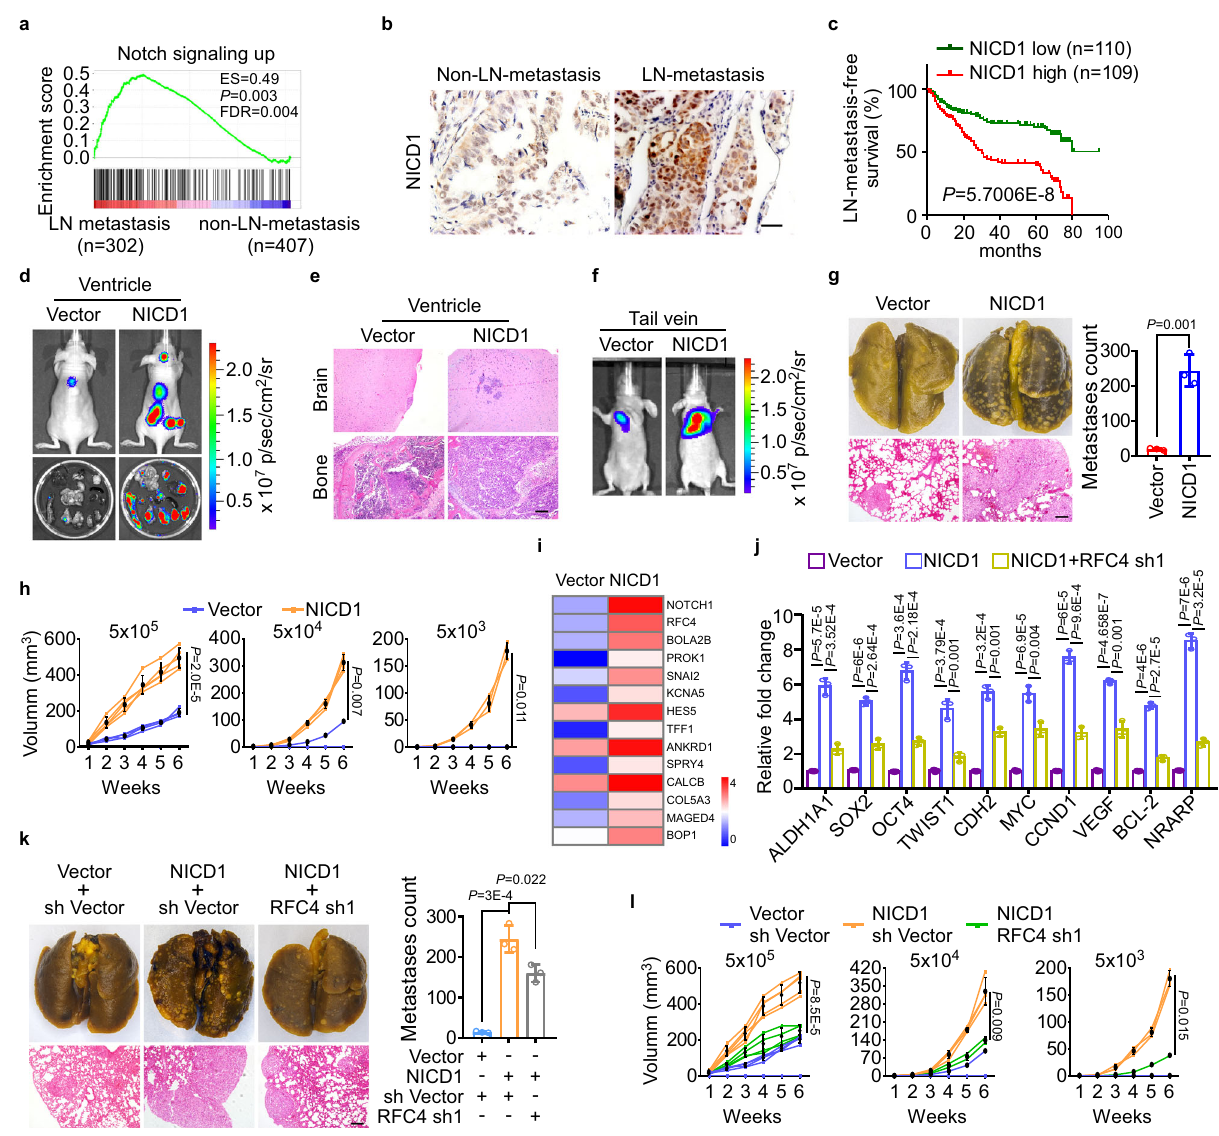
Fig. 1 RFC4 is essential for Notch activation-induced metastasis and stemness of NSCLC. a GSEA analysis of gene expression pro fi les of NSCLC patients with or without lymphatic node (LN) metastasis in the TCGA lung cancer datasets by Kolmogorov – Smirnov test. b IHC determined NICD1 expression in primary tumors of our cohort of 219 NSCLC patients with or without LN metastasis. Two representative cases are shown. Scale bar: 20 μ m. c Kaplan – Meier analysis of LN metastasis-free survival of our 219 NSCLC patients by log-rank test, who were divided into low- or high- subgroups according to the median of NICD1 expression. d , e A549-luci-Vector or A549-luci-NICD1 cells were injected via cardiac ventricle into nude mice ( n = 5 per group). Representative bioluminescent images of systemic metastasis and ex vivo organ metastases are shown ( d ), H&E histologically con fi rmed tumor cells in bone and brain tissue ( e ). Two representative cases are shown. Scale bar: 100 μ m. f , g Nude mice were intravenously injected with A549-luci-Vector or A549-luci-NICD1 cells ( n = 5 per group). Representative bioluminescent images ( f ), picric acid staining, H&E staining, and the numbers of metastatic foci of lung tissue are shown ( g ). Two representative cases are shown. Scale bar: 100 μ m. h Growth curves of tumor xenografts of the indicated cells subcutaneously implanted with different cell numbers and tumor formation frequencies are shown. i Gene expression array analysis showed the most upregulated 10 genes induced by NICD1 overexpression. j The effect of silencing RFC4 on expression of the indicated mRNAs in NICD1-overexpressing cells. k , l The abilities of overexpressing NICD1 or together with RFC4-silenced A549 cells colonize in the lung or to generate tumor xenografts ( n = 5 per group). Three representative cases are shown. Scale bar: 100 μ m. Error bars represent the means ± SD derived from three independent experiments. Statistical analyses were performed by two-tailed unpaired Student ’ s t -test ( g ), two-way ANOVA multiple comparison analysis ( h , j – l ). Source data are provided as a Source Data fi le.